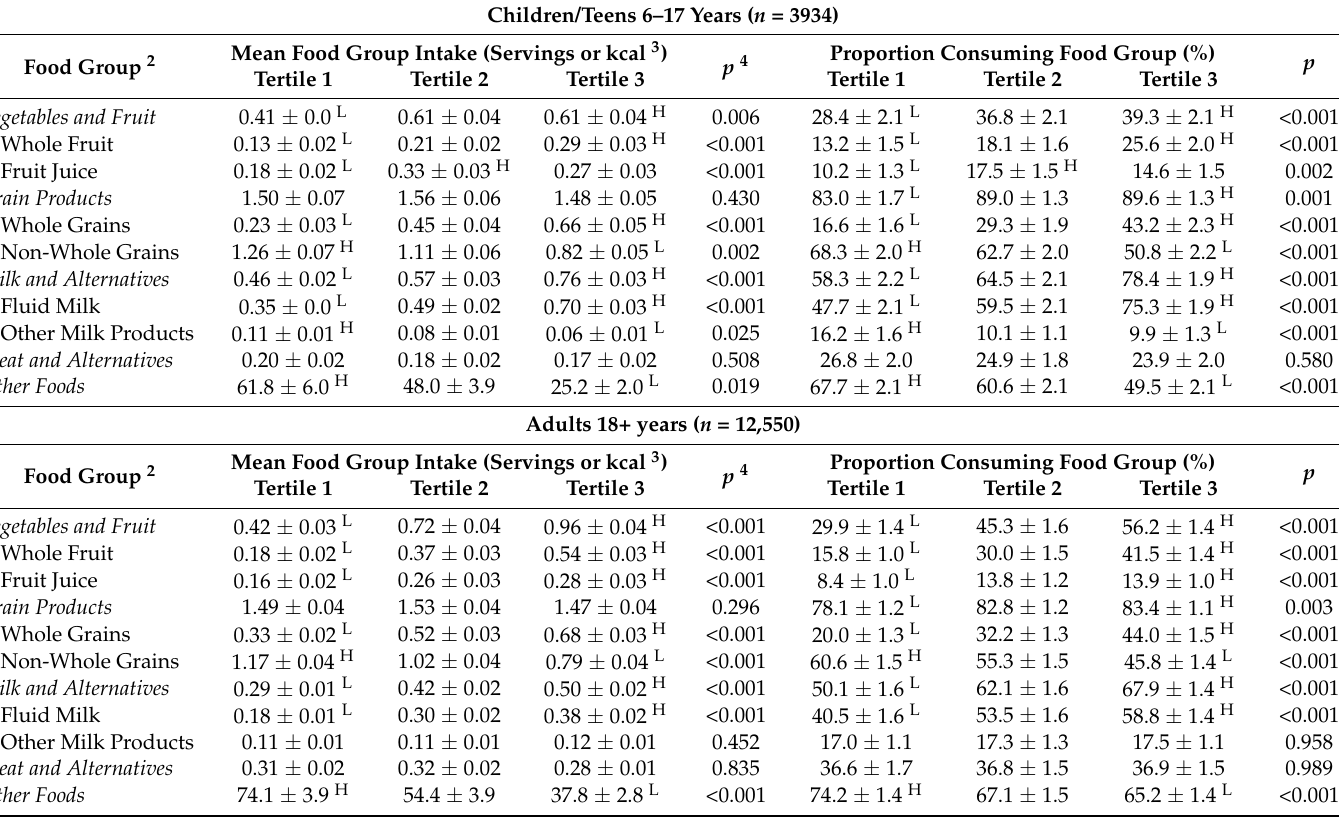
Table 5. Mean food group intake at breakfast and proportions consuming food groups at breakfast by the daily Nutrient-Rich Foods Index 9.3 tertile among Canadian children/teens and adults 1